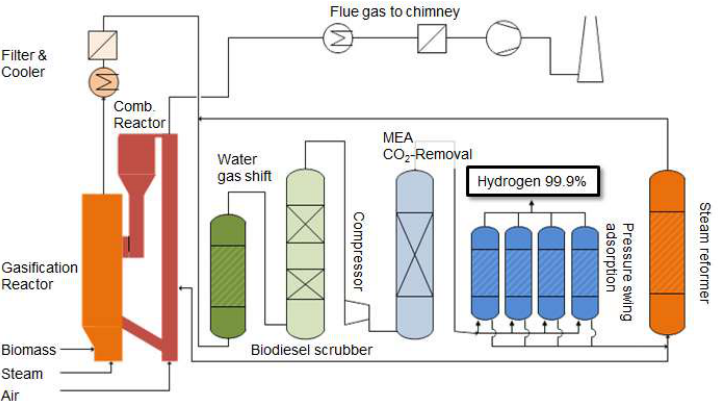
Figure 2. Flow scheme of a hydrogen production plant based on dual fluidized steam gasification of biomass.